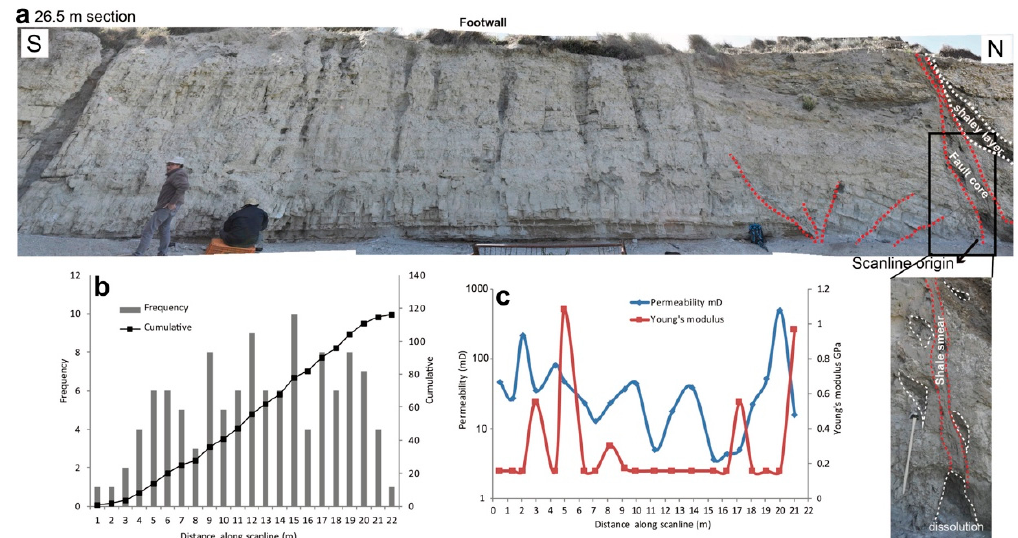
Figure 10. ( a ) Section 1 in Altichuelas site (southern segment of the Baza Fault), where the first scanline was conducted at the base of the outcrop. Note the fault in the northern corner of this outcrop with a clay smear and many cavities/dissolution features around the fault. The scanlines were conducted in the footwall damage zone of this fault. There are several small faults, illustrated with red dashed lines that are either synthetic or antithetic to the orientation of the main fault. ( b ) Frequency and cumulative distribution of fractures along the scanline. ( c ) Permeability and Young’s modulus estimations along the scanline.